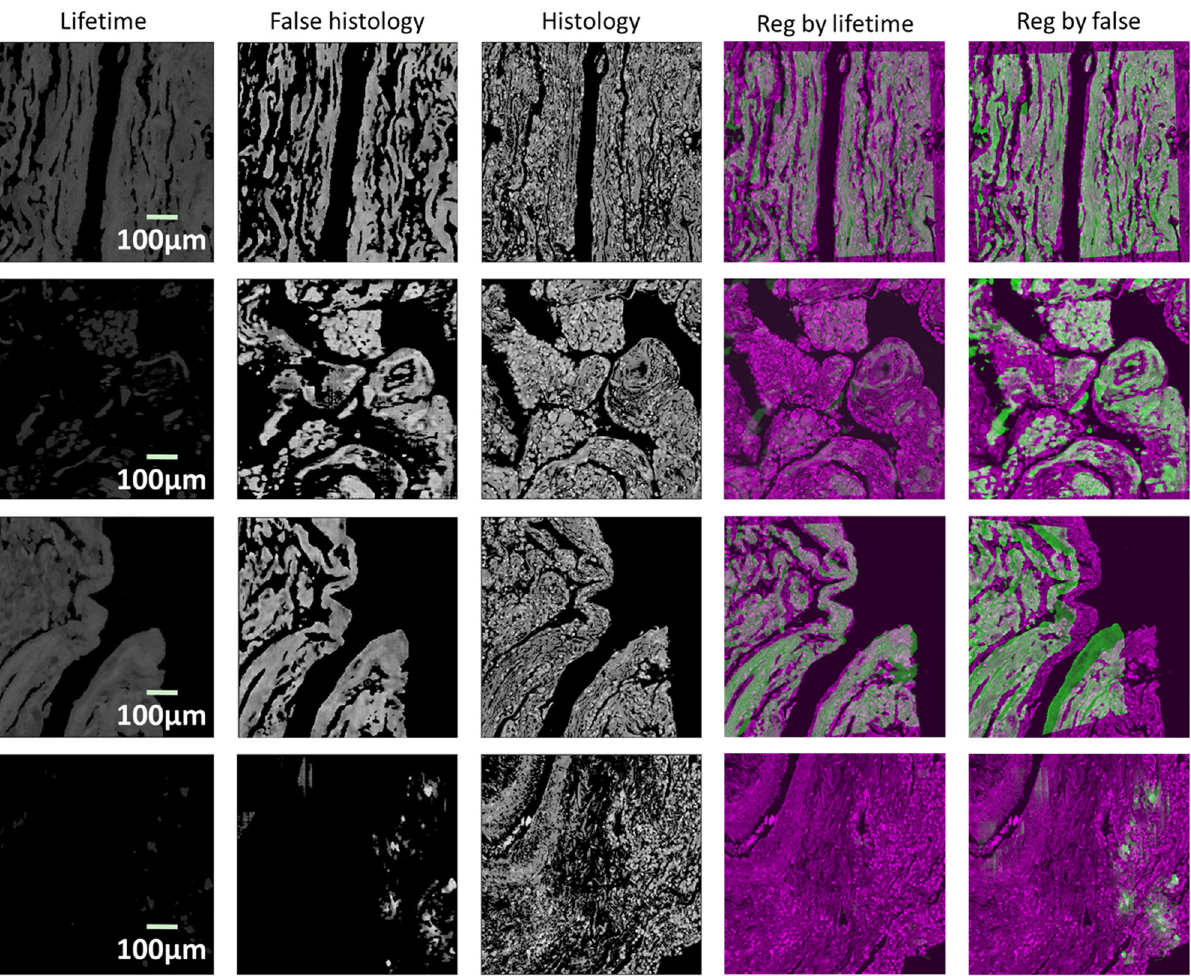
Fig. 5 Comparison of the registration by the lifetime and false histology images. Each row illustrates one speci fi c case where both images present good registration results ( fi rst row), the false histology image outperforms the lifetime image (second row), the lifetime image is better than the false one (third row), and neither of them produces an acceptable result (fourth row), respectively.